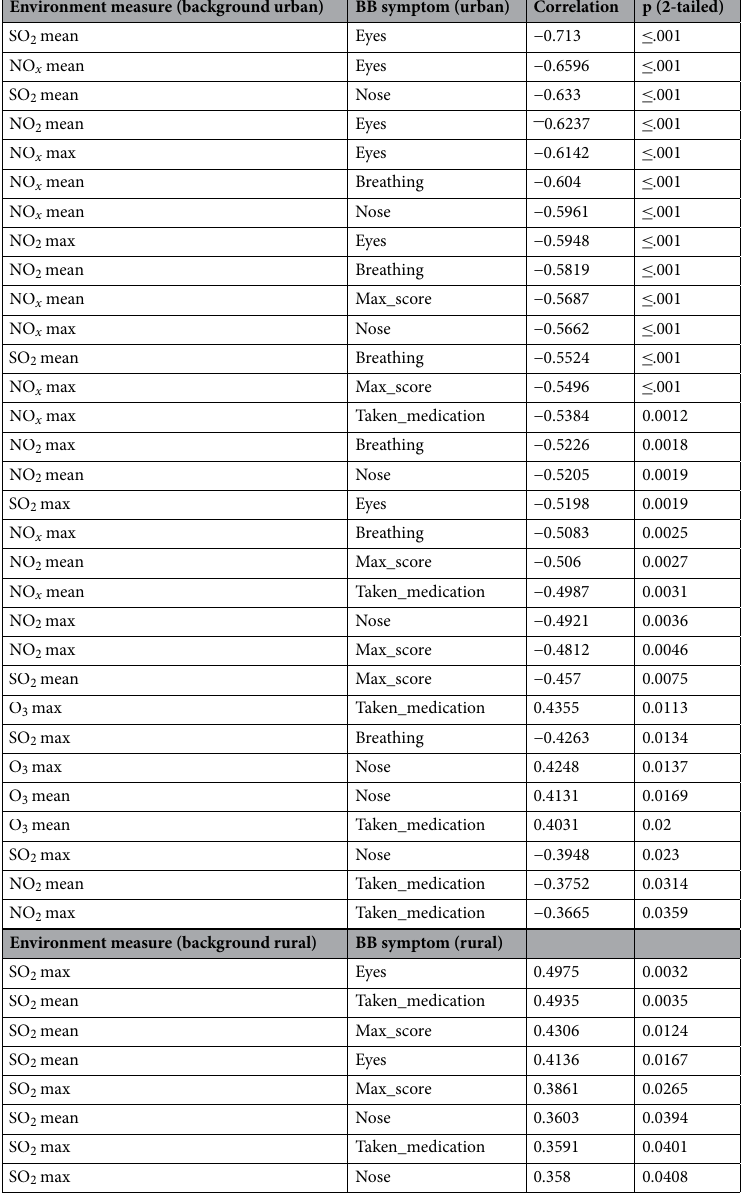
Table 4. Correlations of BB symptom scores with average monthly pollutant variables (UK-wide, but grouped by sensor location type, March–Sept incl.). Only significant correlations (indicated by p values ≤ 0.05) are included